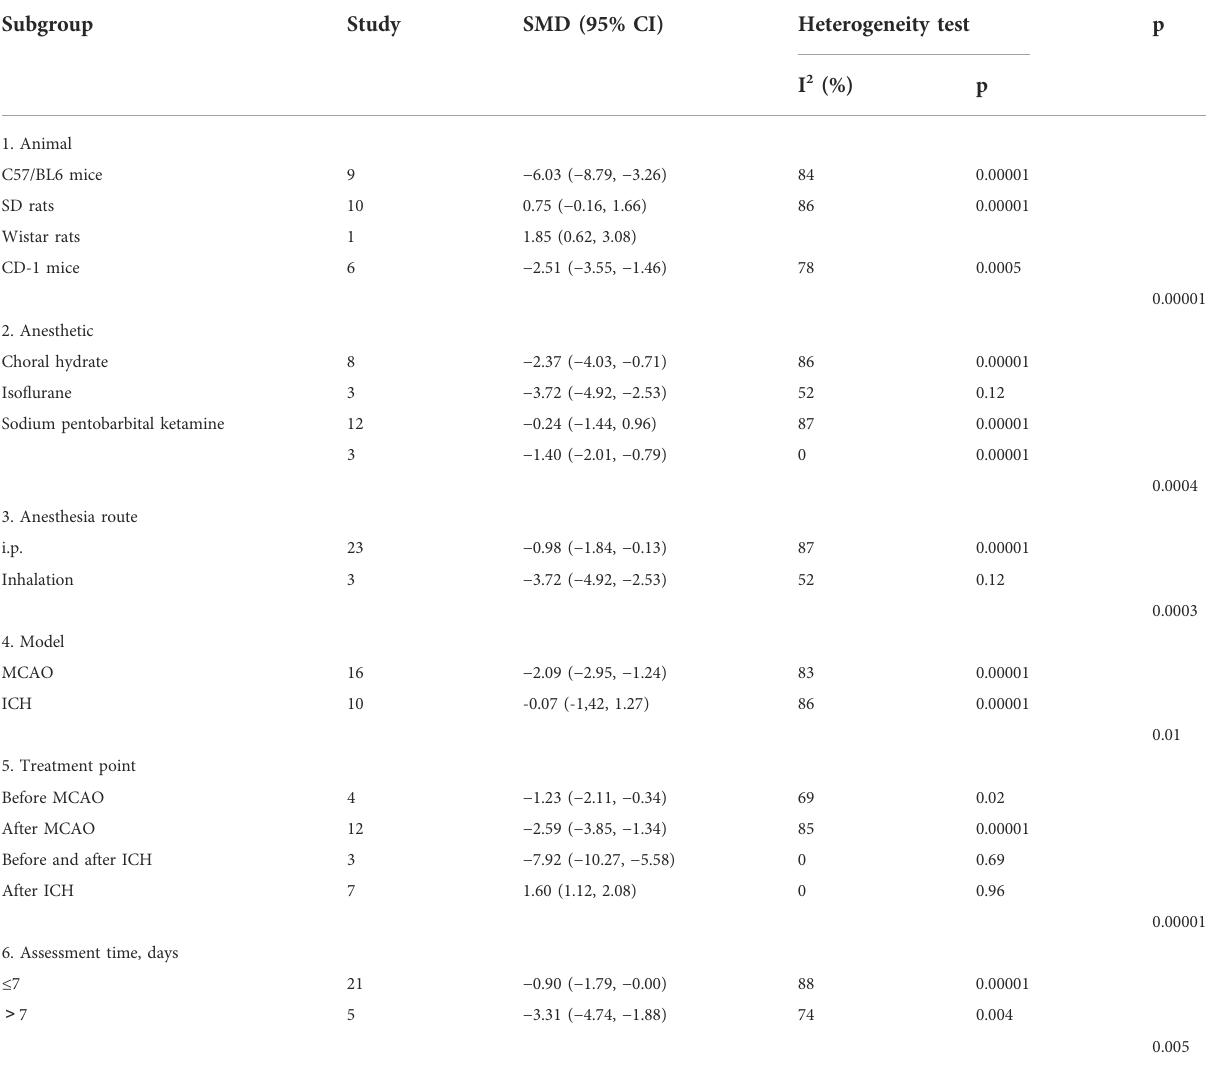
TABLE 3 Strati fi ed meta-analysis of the